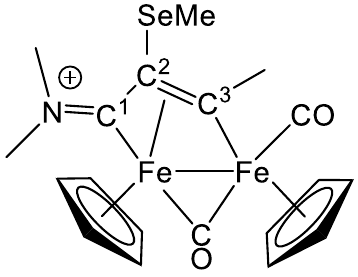
Chart 7. Structure of the cation of 5a .